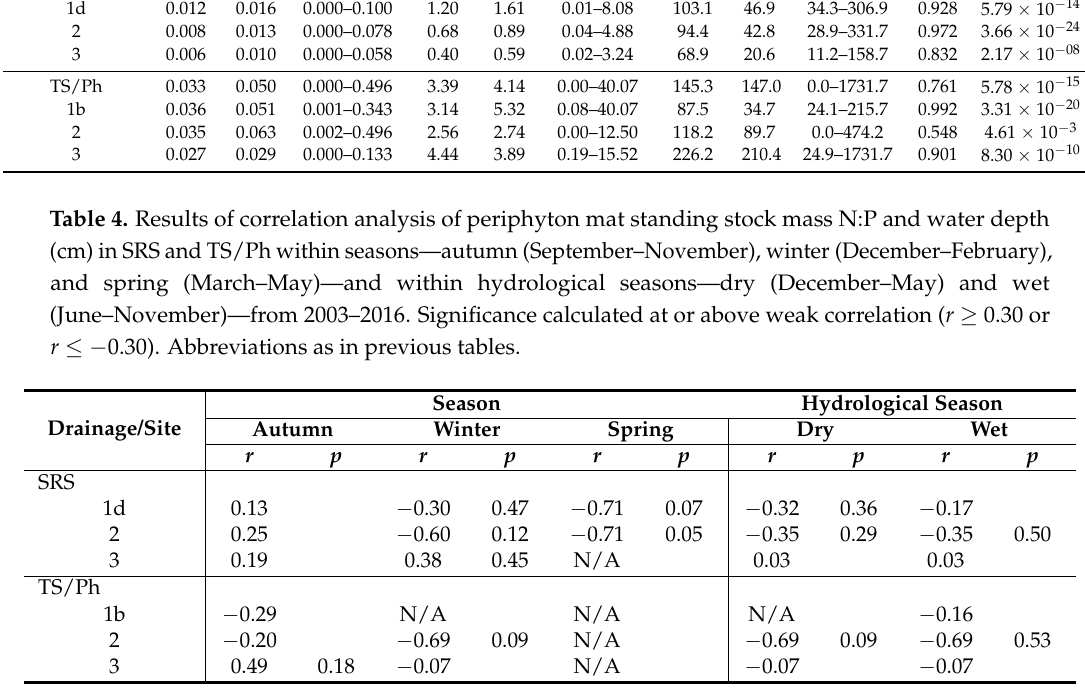
Table 3. Means, standard deviations (SD), and ranges of mat TP and TN in g/m 2 , and the mean mass ratio and correlation coefficient ( r ) and its significance ( p ) of their standing stocks (N:P) collectively as a drainage and at each site in Shark River Slough (SRS) and Taylor Slough (TS/Ph) from 2003–2016. Abbreviations as in Table 2.